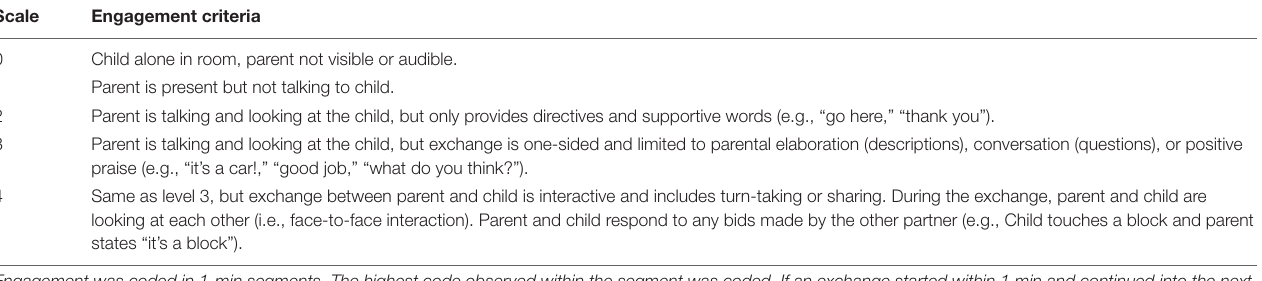
TABLE 2 | Maternal engagement coding scale.